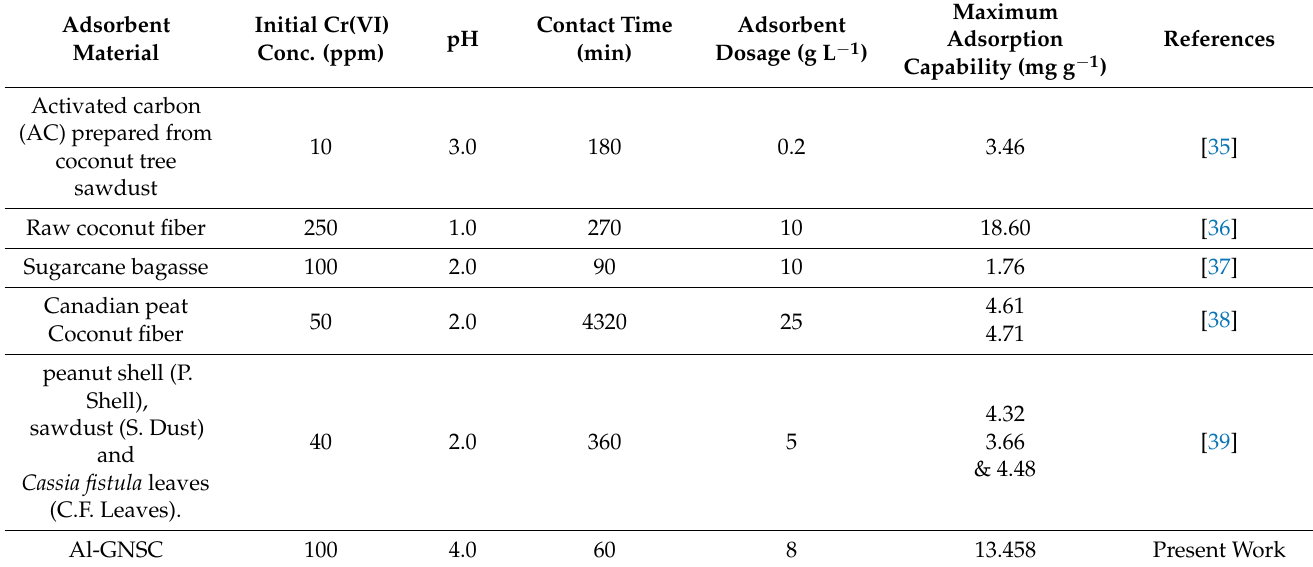
Table 4. Comparison studies of Al-GNSC with other existing adsorbents for the adsorption of Cr(VI).